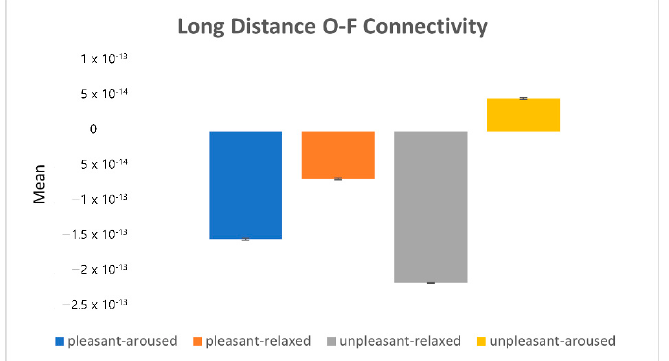
Figure 15. The eigenvalues in the long-distance O-F connectivity.